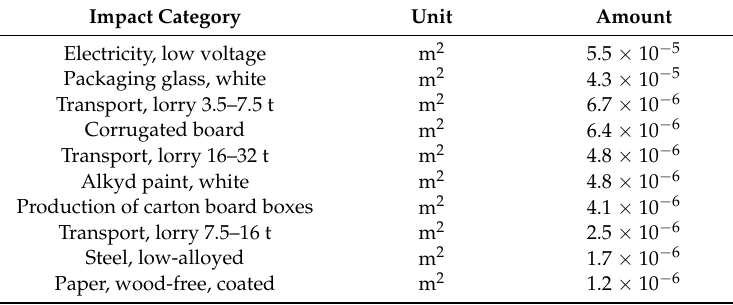
Characterisation results for natural land transformation—first ten processes (30% assumption—extracted from SimaPro (Pr é